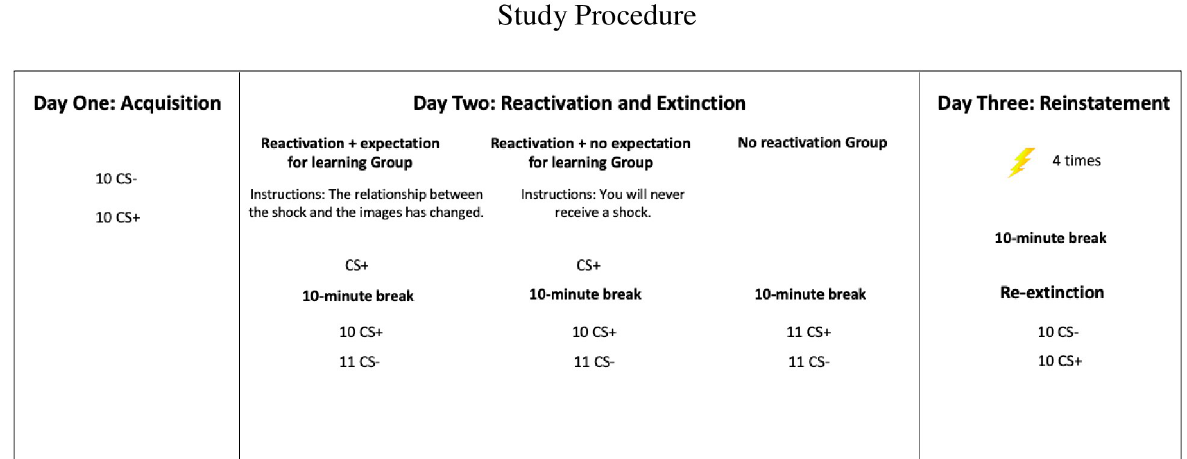
Fig 1. Study procedure. Note . 3-day protocol used for the present study. CS represents ‘conditioned stimulus’ and US represents ‘unconditioned stimulus’. The CS consisted of 2 distinct pictures of spiders and the US was a mild electrical shock. The image that was paired with the shock was counterbalanced across groups. CS+ and CS- presentations were